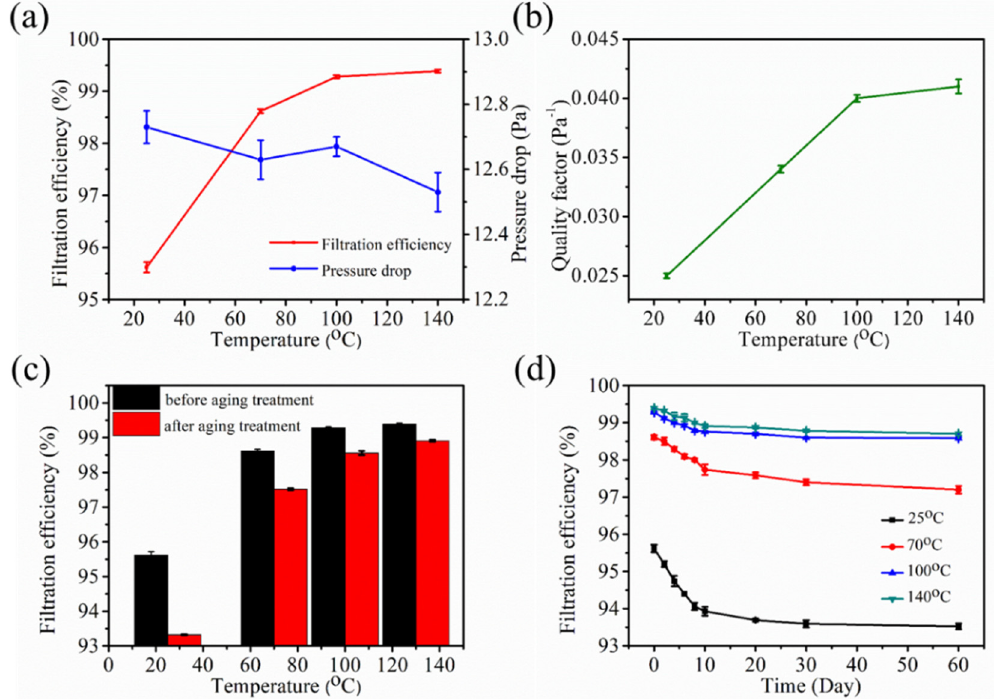
Figure 6. Filtration performances of thermally charged melt blown samples: ( a ) filtration efficiency and pressure drop, ( b ) quality factor ( QF ), ( c ) filtration efficiency decay after the aging treatment, and ( d ) filtration efficiency decay after two months .